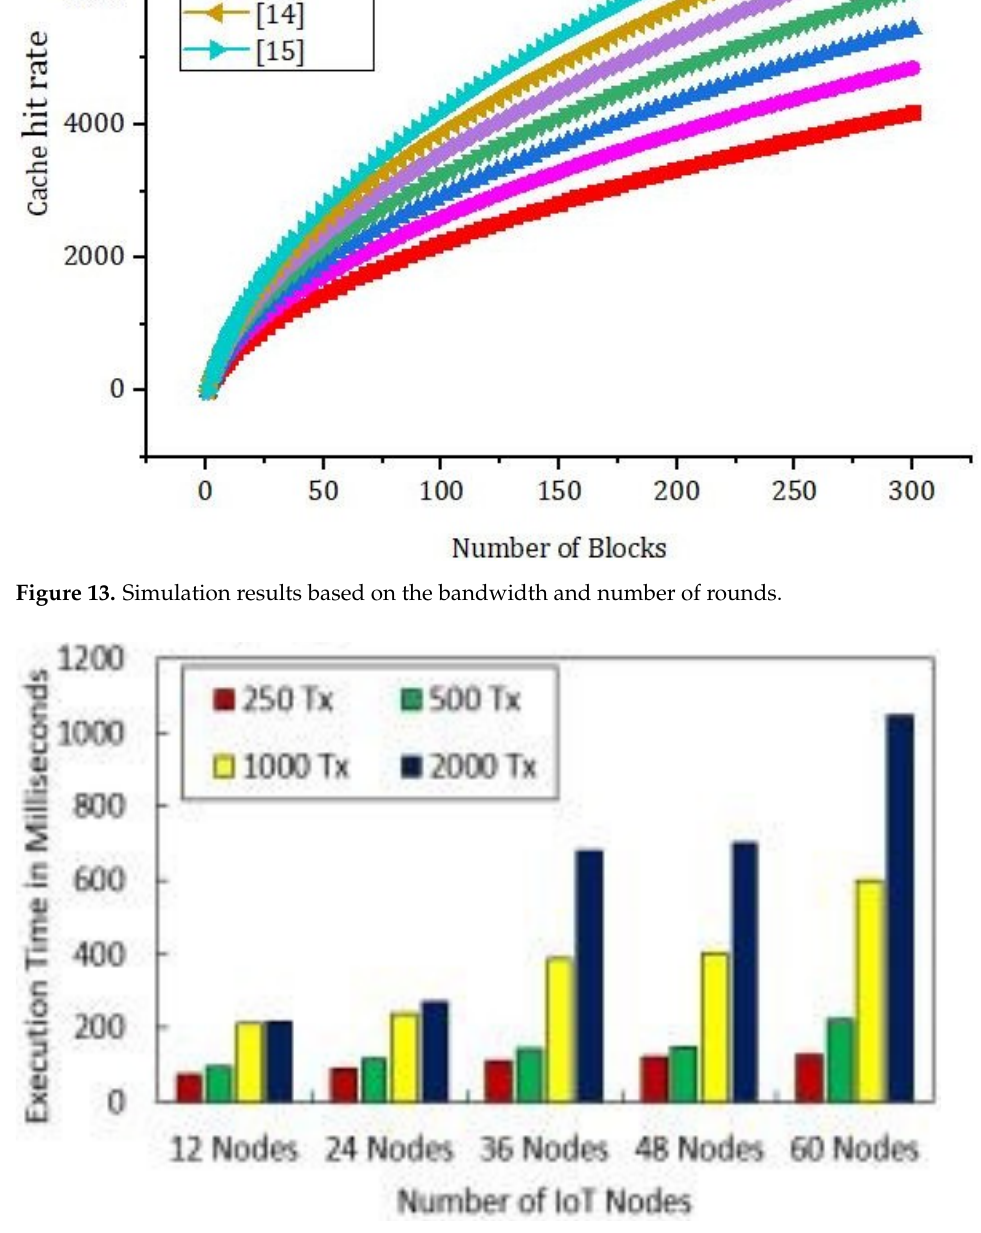
Figure 14. Simulation results based on the bandwidth and number of rounds.